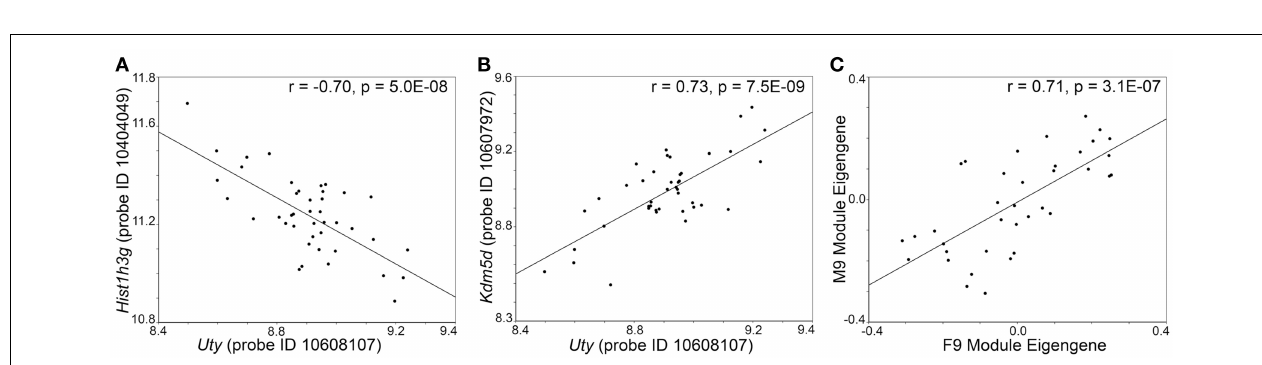
FIGURE 5 | Genetic correlation between transcripts and modules. In the male hypothalamus, expression of Uty is negatively correlated with the histone transcript Hist1h3g (A) and positively correlated with the histone modification transcript Kdm5d (B) .This is a male specific correlation between